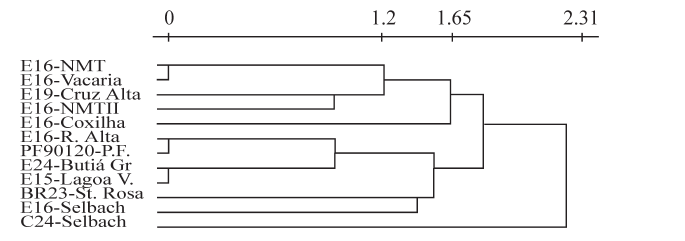
Figure 6 - Dendrogram of the relationships between Drechslera tritici-repentis isolates based on colony morphology only.